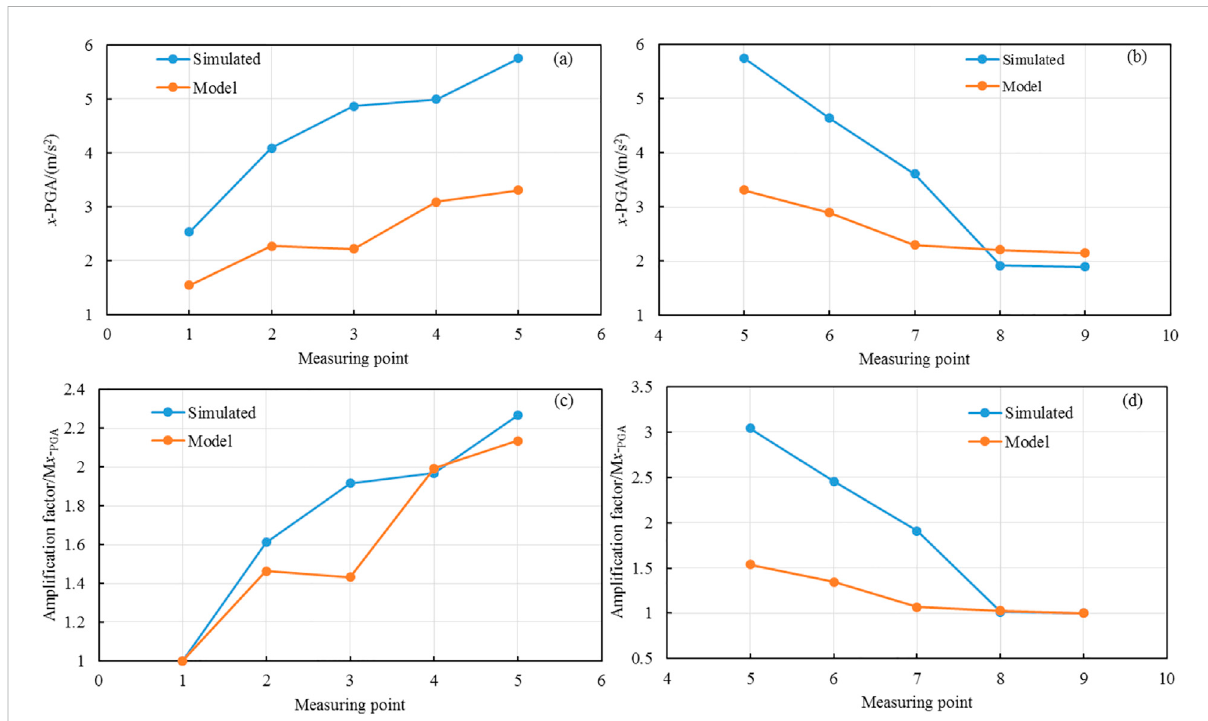
FIGURE 13 Horizontal PGA and ampli fi cation factors of each measurement point of the slope. (a) x-PGA of the loess-slope surface; (b) x-PGA of vertical section; (c) Ampli fi cation factor of x-PGA of the loess-slope surface; (d) Ampli fi cation factor of x-PGA of vertical